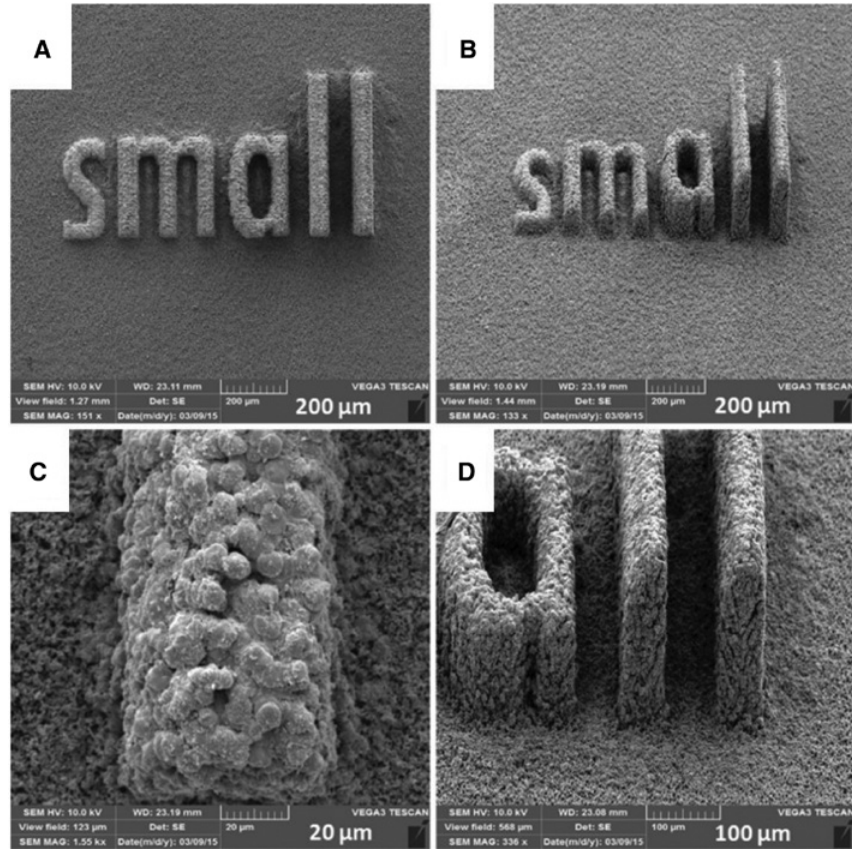
Figure 10: SEM images of the LIFT-printed copper word “Small” on a glass substrate (top view A, tilted view B). The width of the printed letters is 50 μ m and the highs of the letters are gradually increased from 40 μ m to 190 μ m. Zooms to show the morphologies of the printed structures (top view C, tilted view